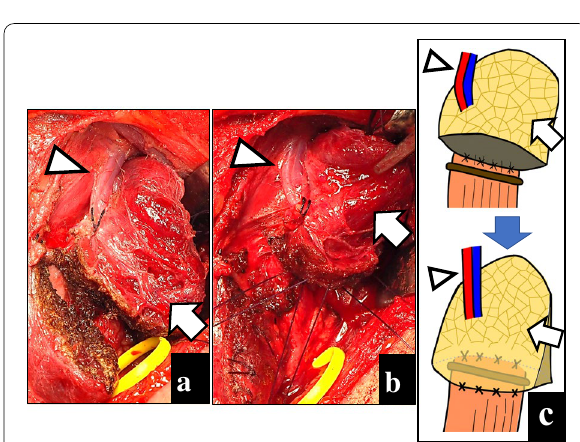
Fig. 4 Photographs and illustrations showing the placement of the thyroid gland flap. a The thyroid gland flap is cut to fit the area of the diverticulectomy before being placed. b The thyroid gland flap is sutured to completely cover the staple line on the cut surface of the thyroid gland. c Schema of the staple line covered by the cut surface of the thyroid gland. Arrowhead: superior thyroid artery and vein; arrow: thyroid gland